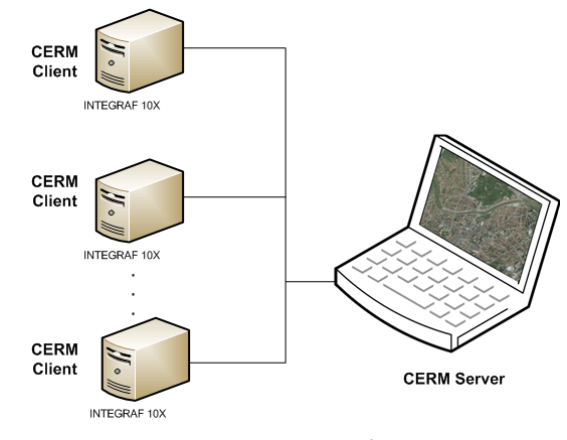
Figure 1. CERM system